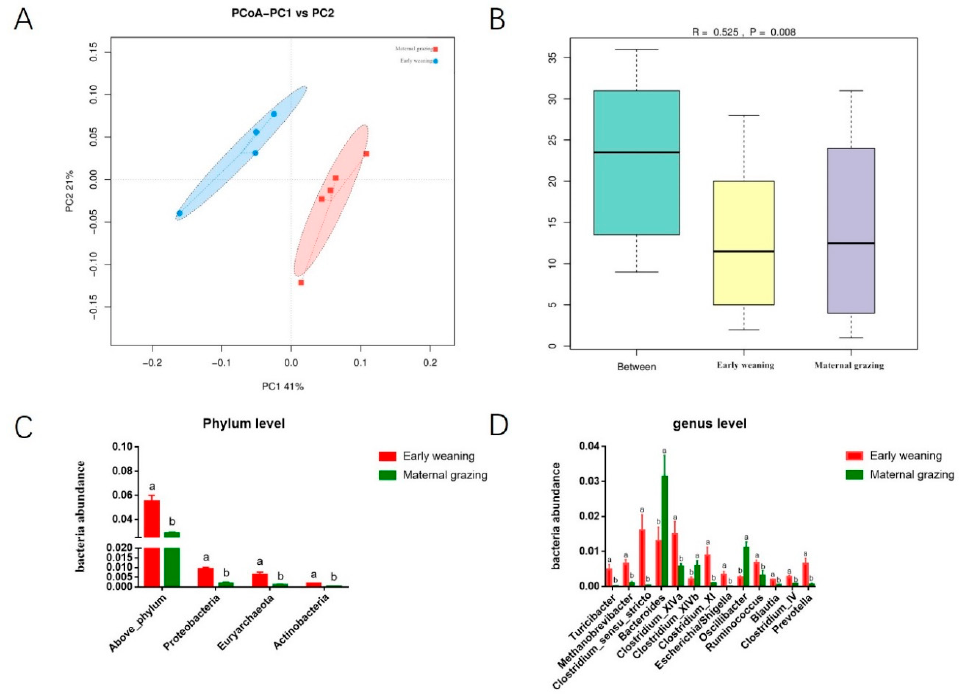
Figure 2. Caecal microbial community difference between the different feeding paradigm groups (n = 4). ( A ) PCoA analysis. ( B ) Anosium analysis. ( C ) Differential caecal microbes at phylum level based on t -test analysis. ( D ) Differential caecal genera based on t -test analysis.